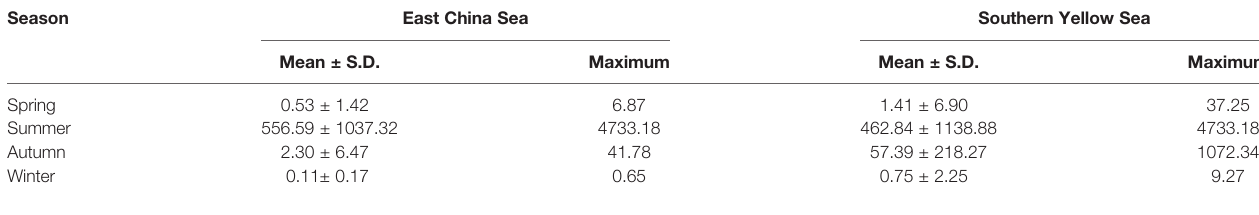
TABLE 2 | The depth-integrated abundance (× 10 4 cells/m 2 ) of N. scintillans using net-collection method in the East China Sea and southern Yellow